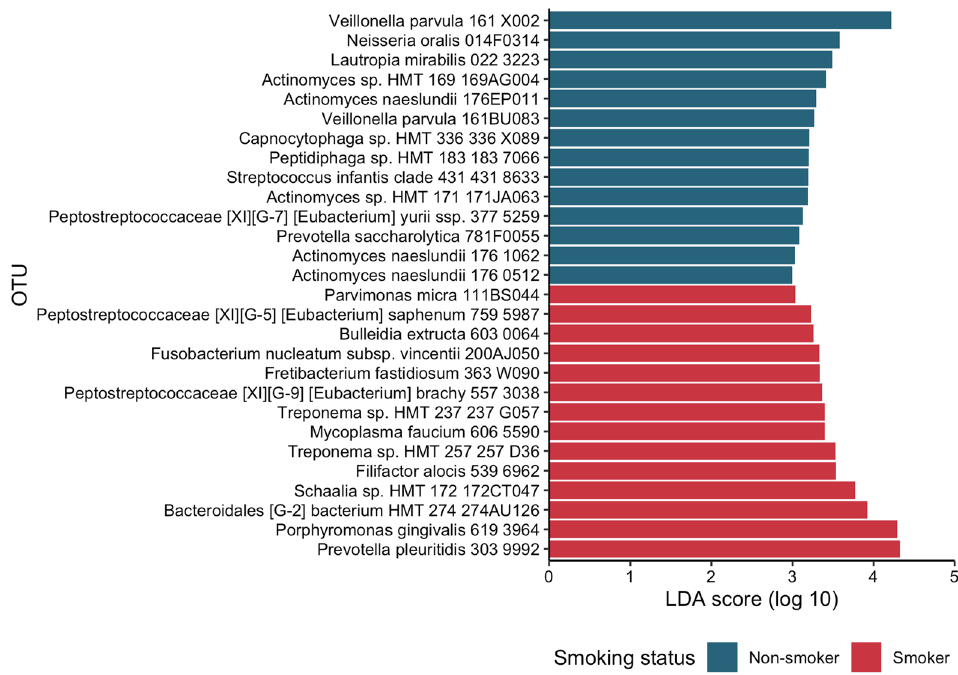
Figure 3. Differentially abundant taxa between smokers and non-smokers. Differentially abundant OTUs were identified using linear discriminant analysis Effect Size (LEfSe). Color indicates the enrichment of the taxa associated with different smoking status. OTU operational taxonomic